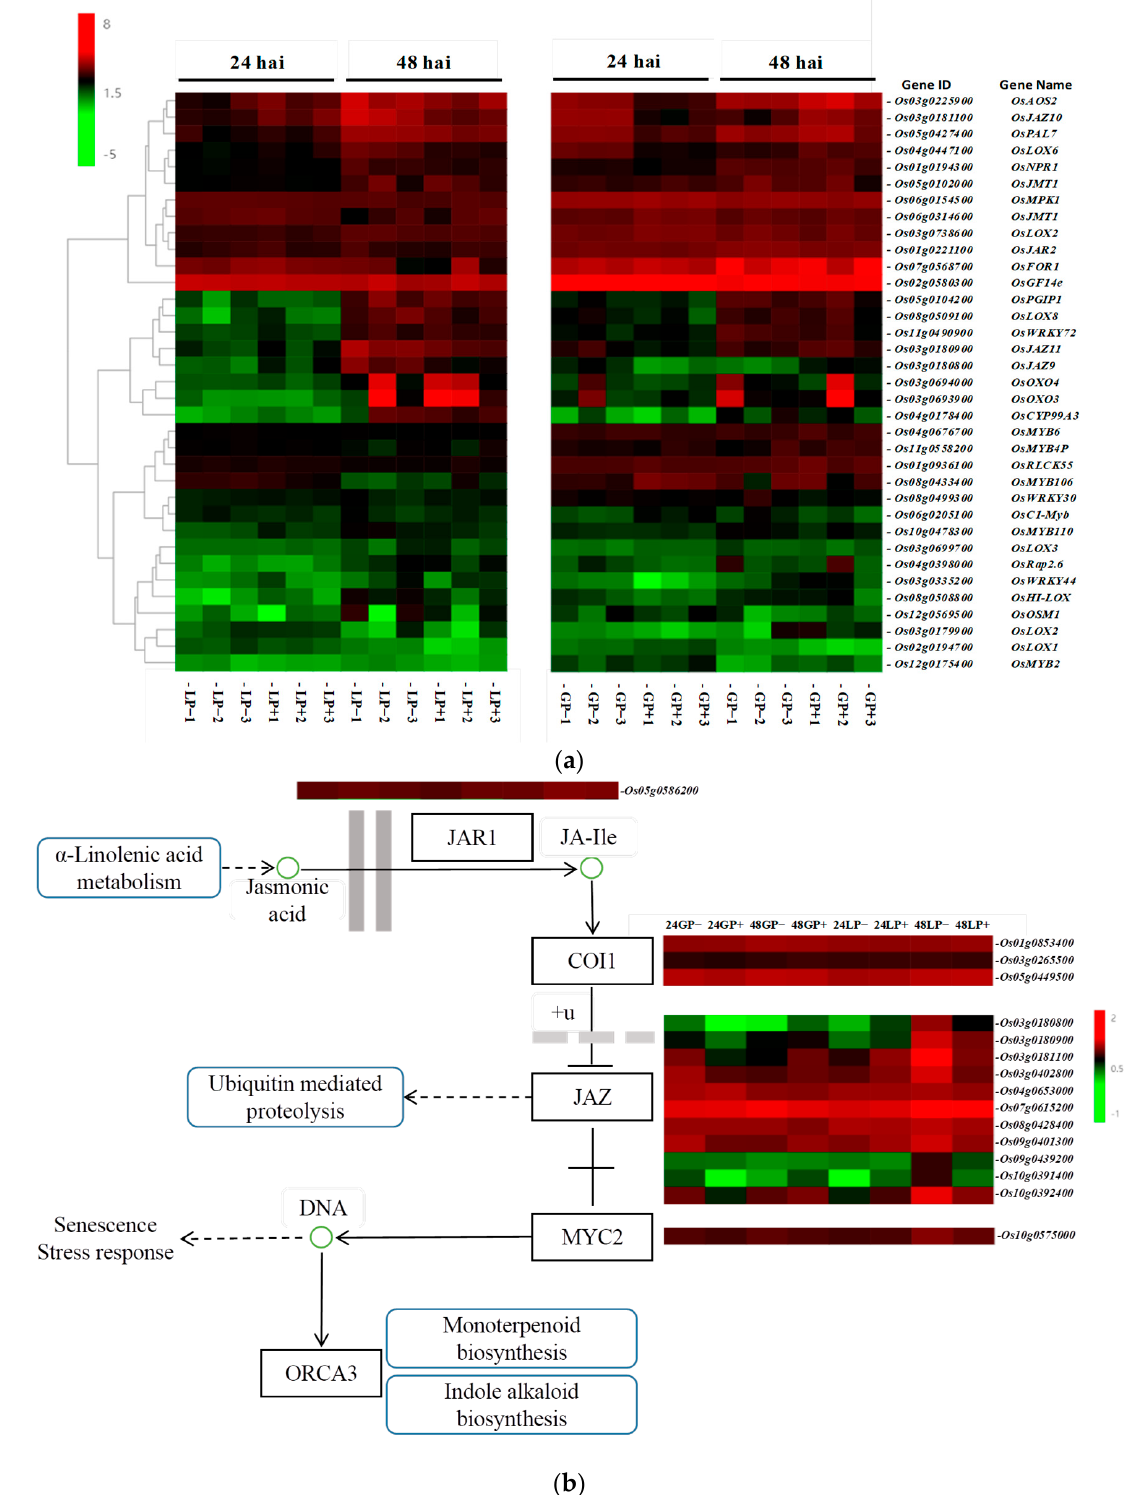
Figure 5. Heatmap of DEGs related to plant disease resistance ( a ) and JA signal transduction pathway ( b ). Heatmap was generated using the values [log2(FPKM)], representing the relative expression levels of DEGs in the leaf sheath of rice. The color bar indicates the expression values as an increasing intensity gradient (green, low expression; red, high expression).